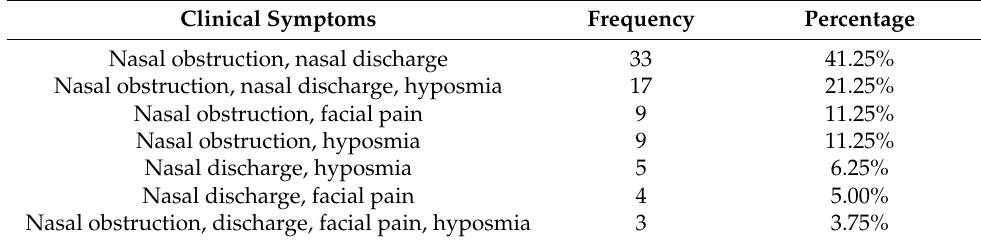
Table 1. Distribution of presenting complaints of study